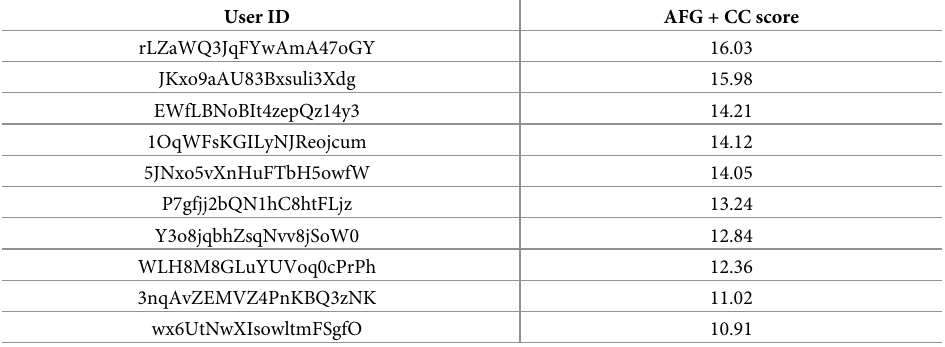
Table 2. List of emerging influencers.